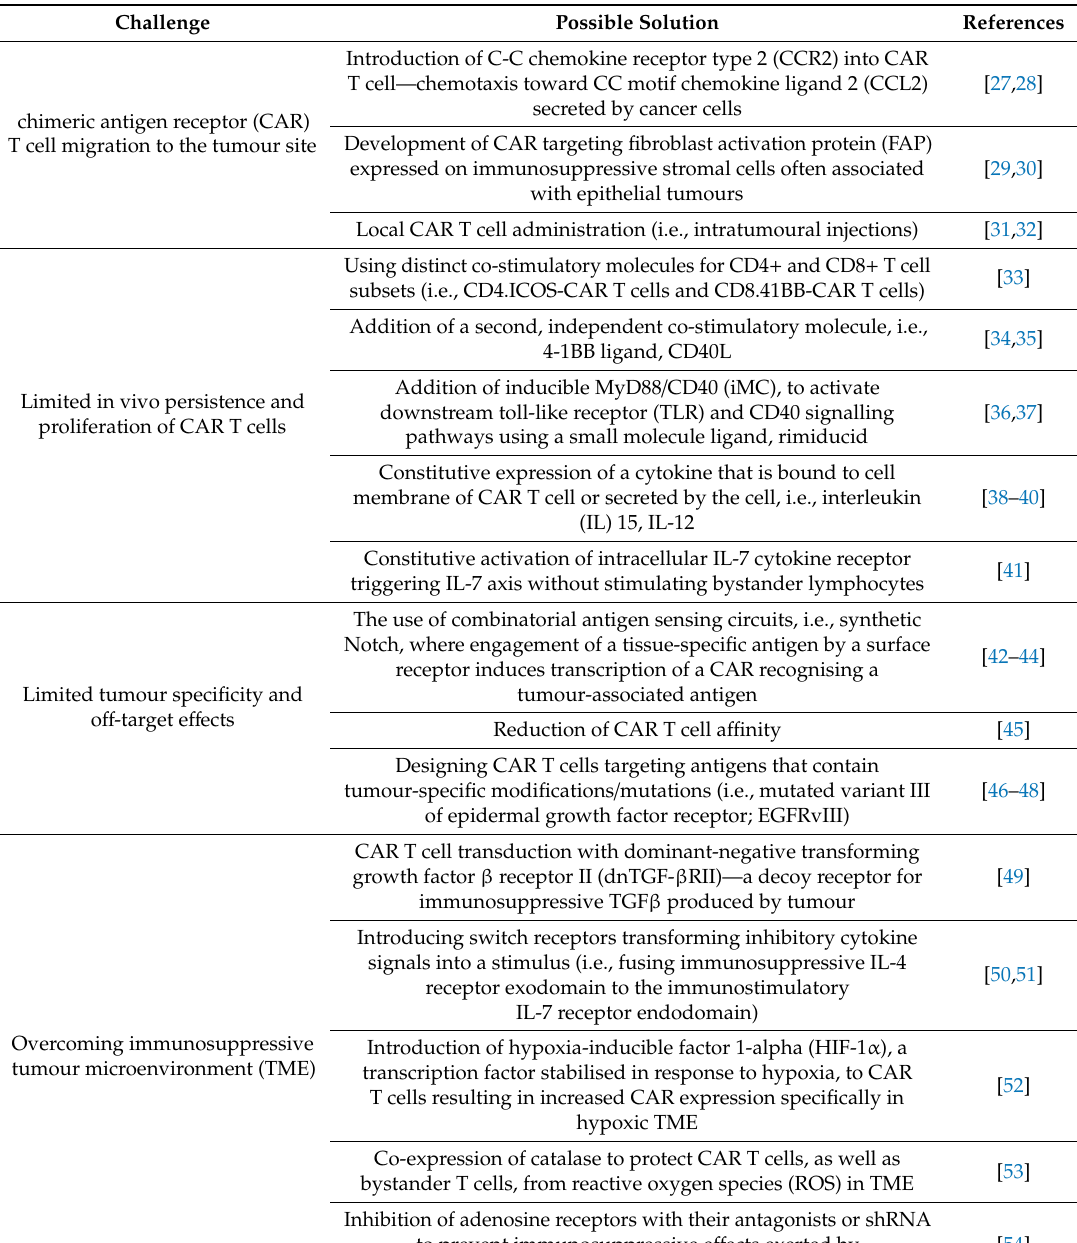
Table 1. Strategies for improvement of Chimeric Antigen Receptor (CAR) T cell therapies for solid